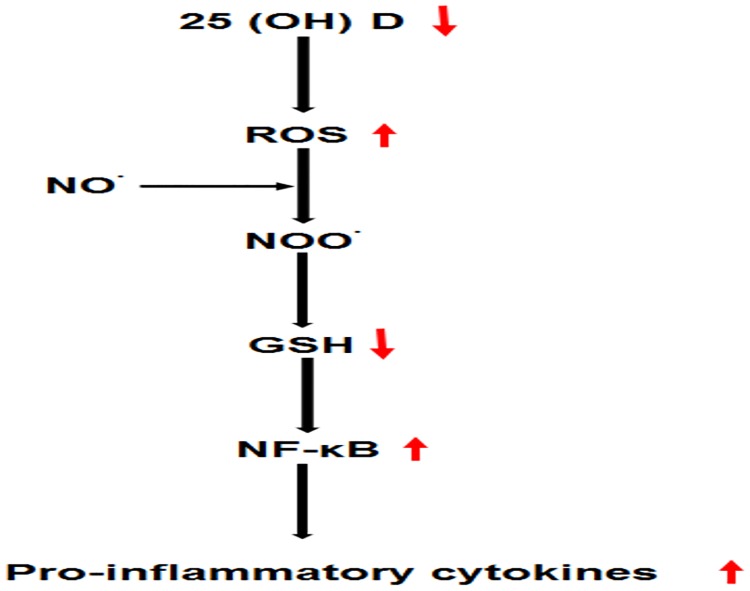
Schematic diagram showing 25 (OH) D mediated production of inflammatory cytokines.25 (OH) D regulates the formation of reactive oxygen species, therefore a decrease in 25 (OH) D favours the ROS formation. ROS along with nitric oxide forms highly reactive peroxynitrite which has the potential to deplete antioxidants. As a result redox balance is disturbed thus favouring the formation of pro-inflammatory cytokines due to activation of signalling pathways (NF-κB).